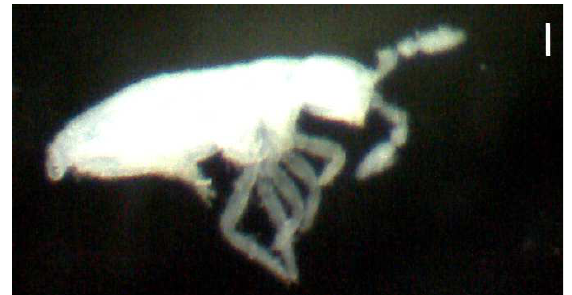
Figure 12. Body shape of C. albinus (scale: 1000 µm) .